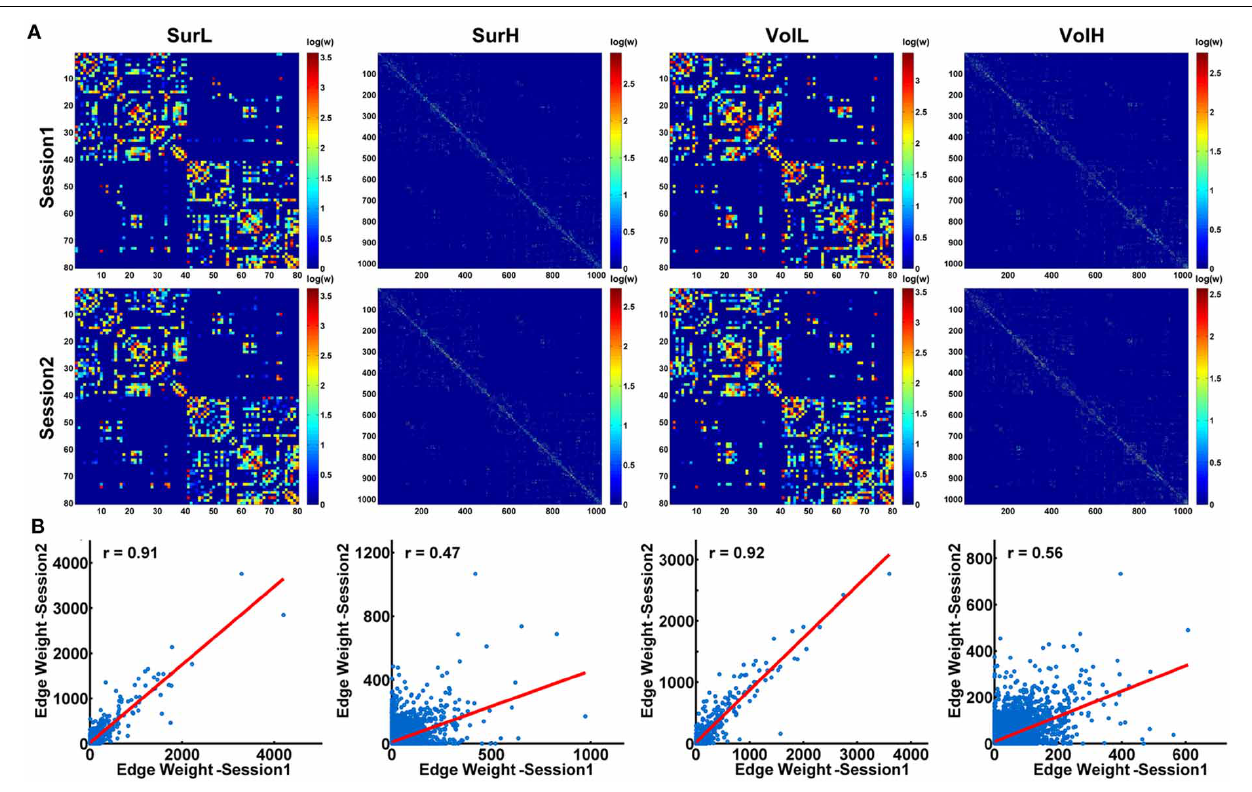
FIGURE 7 | The correlation of structural connection matrices between sessions. (A) For each session, the backbone of the WM network under different construction procedures was shown in a matrix. (B) Between the